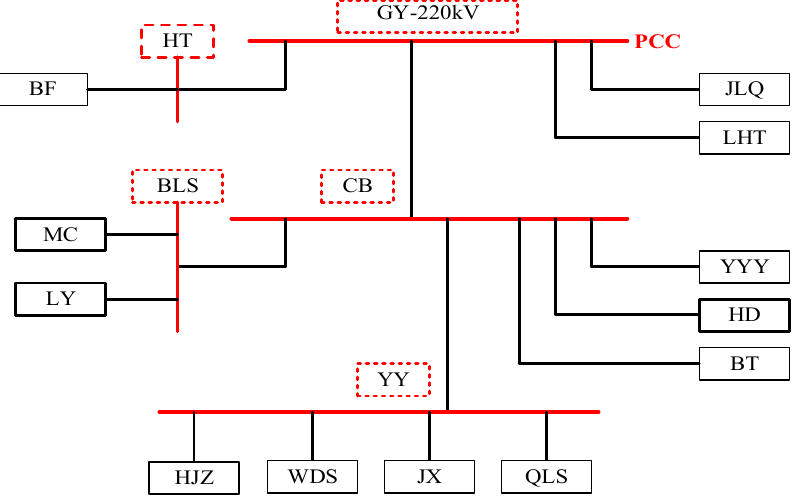
Figure 11. The topology of a practical wind farm base in Northeast